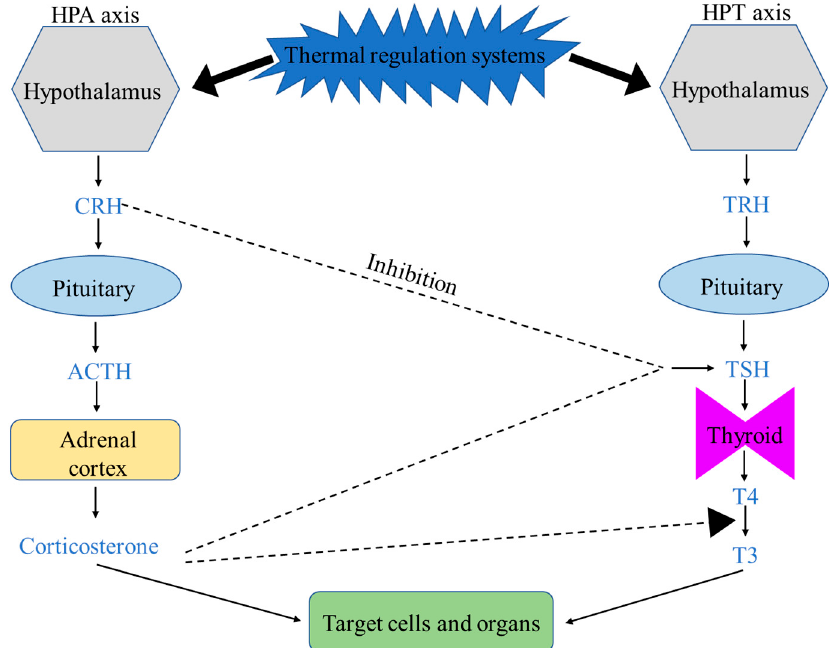
Figure 1. The major thermal regulation systems in chickens: the HPA axis and HPT axis and their interactions. ACTH: adrenocorticotropic hormone, CRH: corticotropin-releasing hormone, HPA: the hypothalamic–pituitary–adrenal, HPT: hypothalamic–pituitary–thyroid, T3: 3,5,3 ′ -triiodothy-